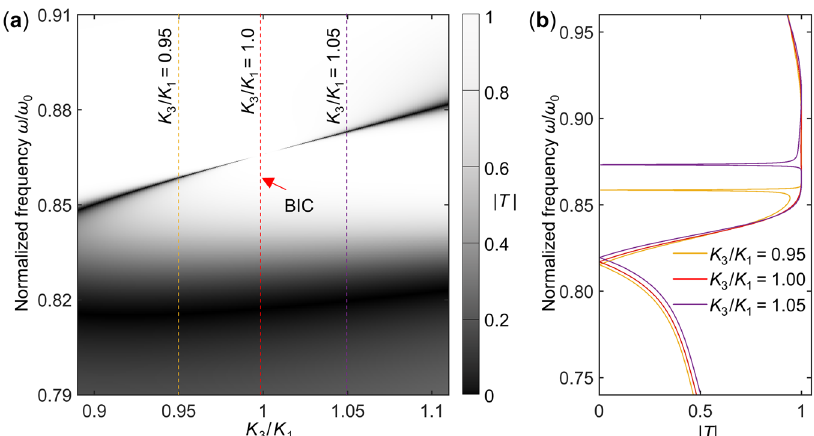
Fig. 4 Zoomed-in view of the BIC and sharp resonances. a Zoomed-in view of the bound-states-in-the-continuum (BIC) point highlighted by the yellow box in Fig. 3a. b Cuts through the data in panel a at three selected ratios K 3 = K 1 (see dashed vertical lines in a ). Extremely sharp resonance versus frequency ω occur for parameters close to the BIC point (yellow and purple curves). At the BIC point (red curve), the sharp resonance disappears as incident waves strictly do not couple to the